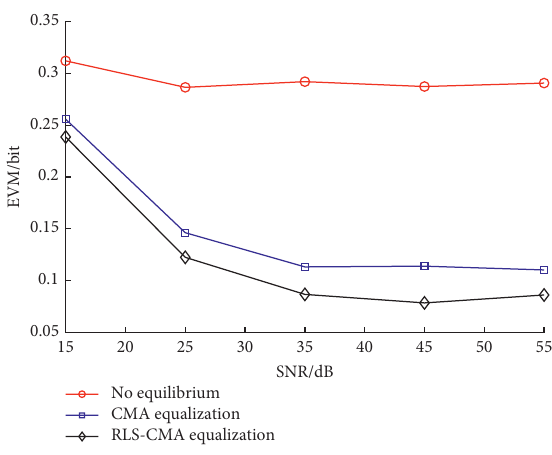
Figure 12: BPSK EVM curves.